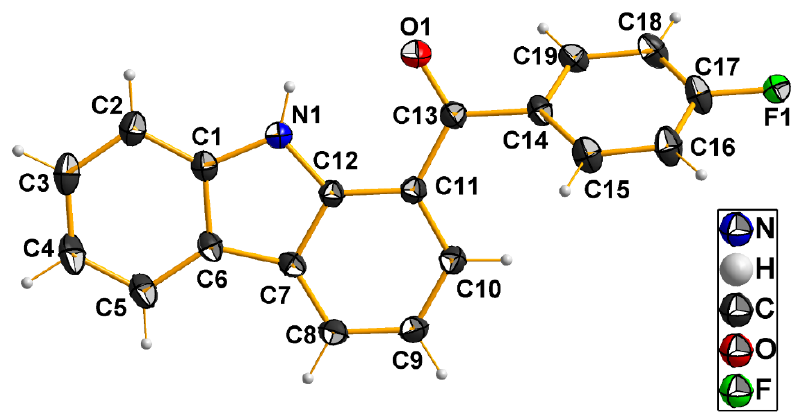
Figure 1. Molecular structure (ORTEP plot at 50% probability) of compound 1 .